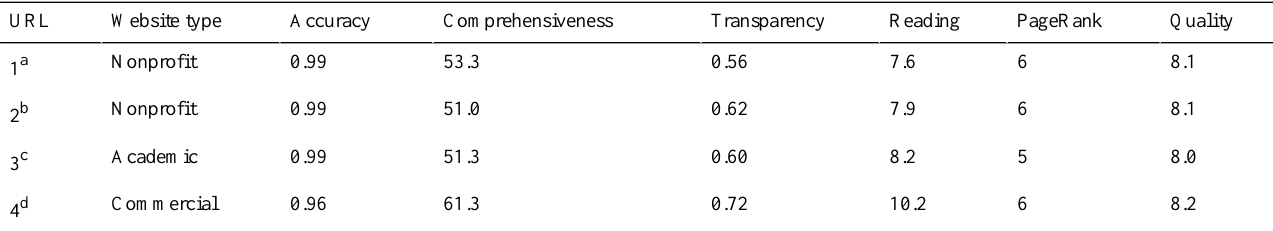
Table 2. URLs, website type, accuracy, comprehensiveness, transparency, reading grade level, PageRank, and quality scores of websites with quality scores of 8.0 or